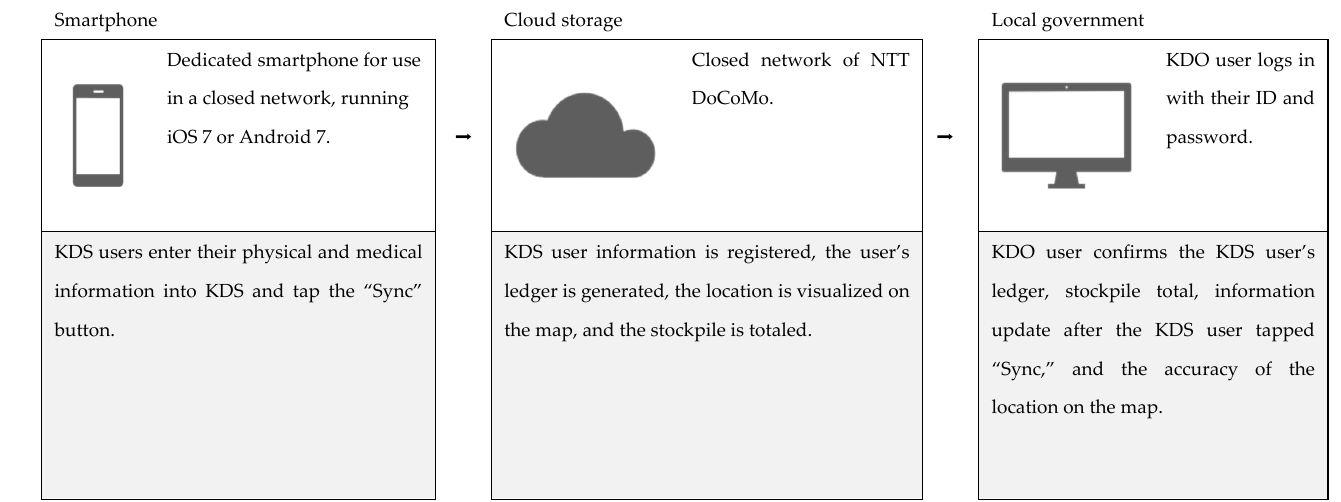
Figure 3. Workflow of the system.